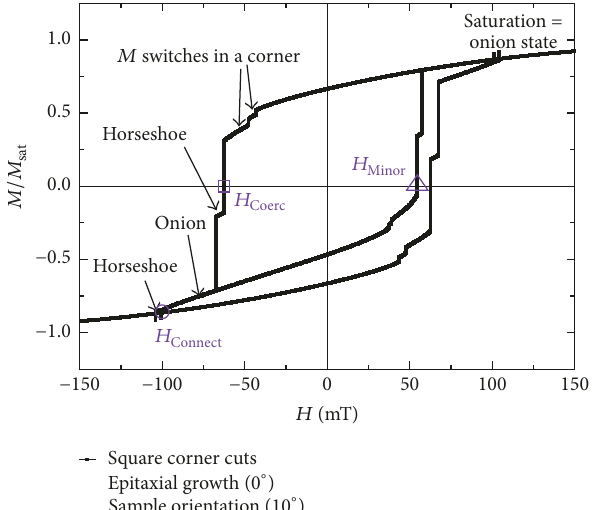
Figure 2: Sample hysteresis loop with the main magnetization states identified as onion and horseshoe states. Lilac marks depict the coercive field 𝐻 Coerc as well as the fields defined as 𝐻 Connect and 𝐻 Minor .